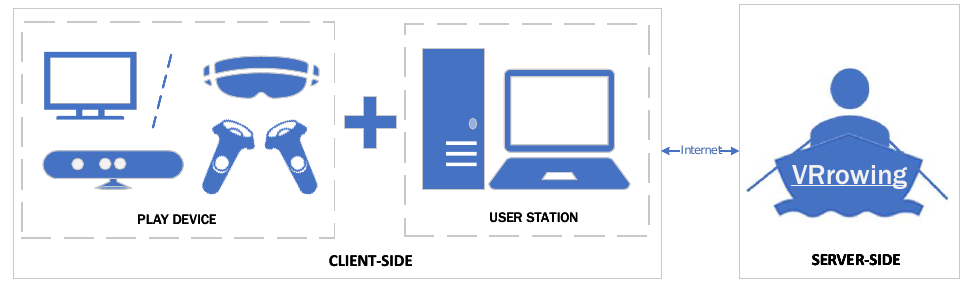
Figure 1. The system architecture of VRrowing